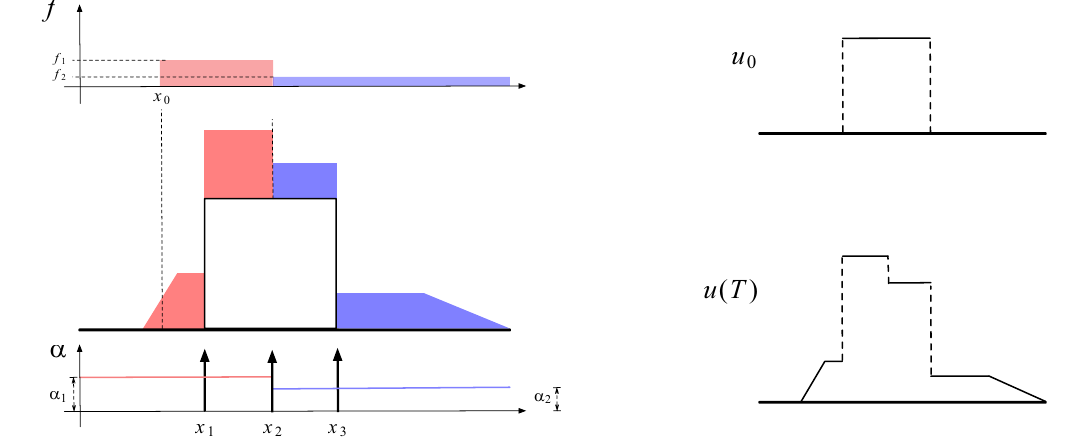
Figure 1: Accumulation of two kinds ( red and blue ) of granular materials on discontinuous surface. ( Left ) Depiction